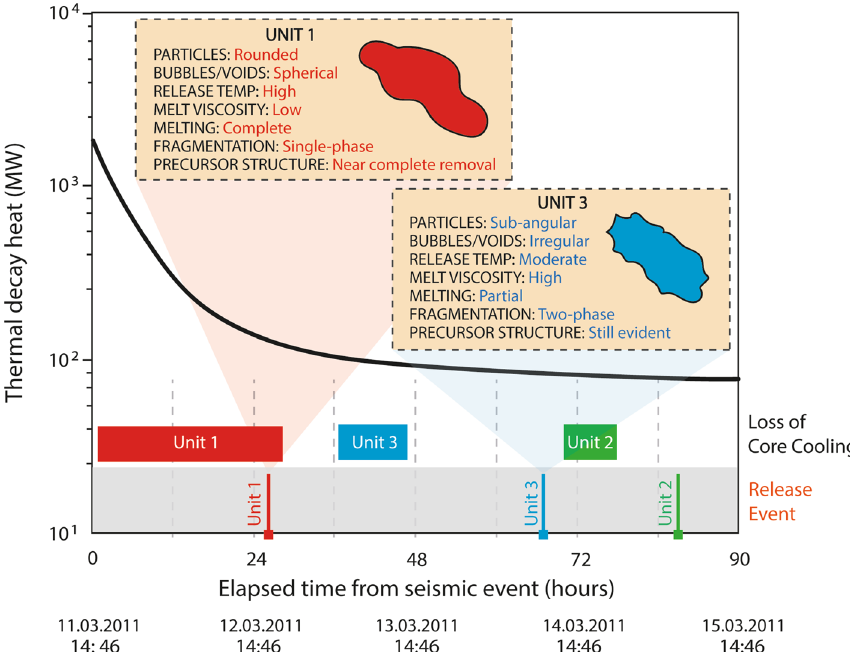
Figure 9. Schematic representation of reactor Unit 1 and Unit 3 particulate formation chronologies, alongside each suites resultant structural (internal and external) characteristics, and as observed during this study, the invoked conditions of